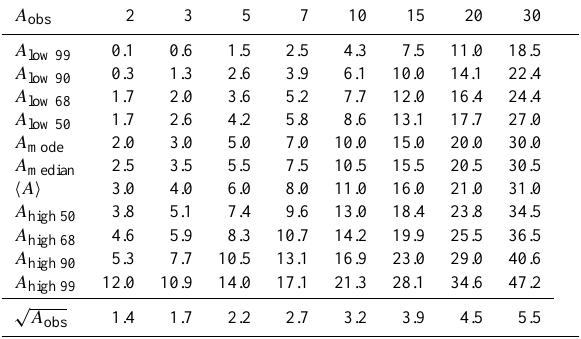
Table 1. Posteriori distributions of a Poisson peak with a given am- plitude A obs , and no background